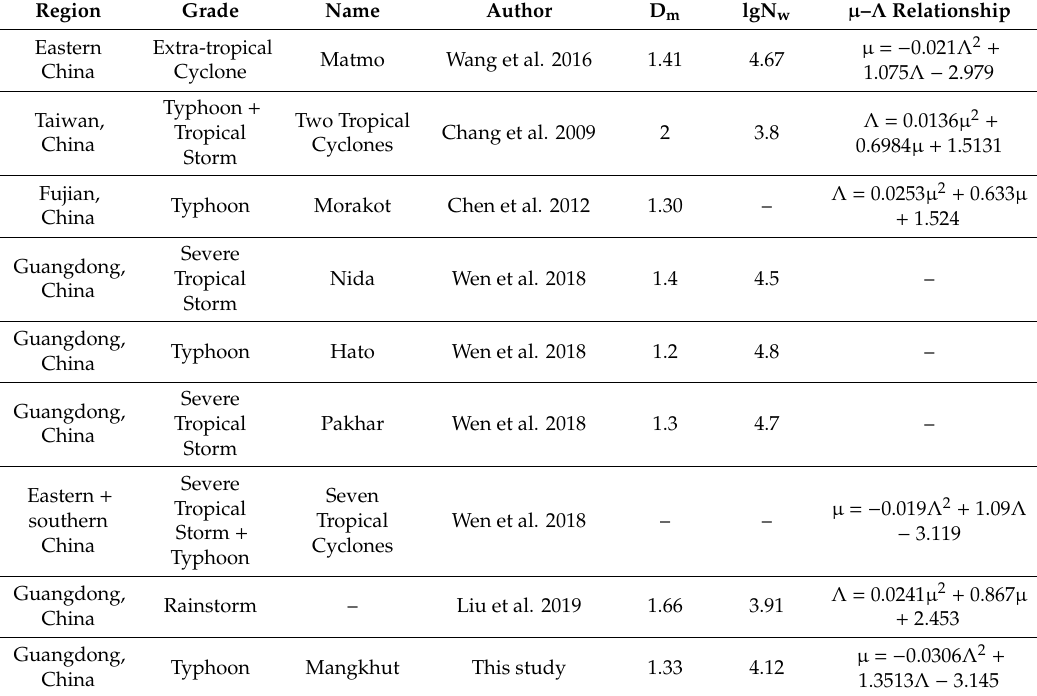
Table3. MeanD m andlgN w valuesand µ – Λ relationshipofvarioustropicalcyclonesindi ff erentregions.